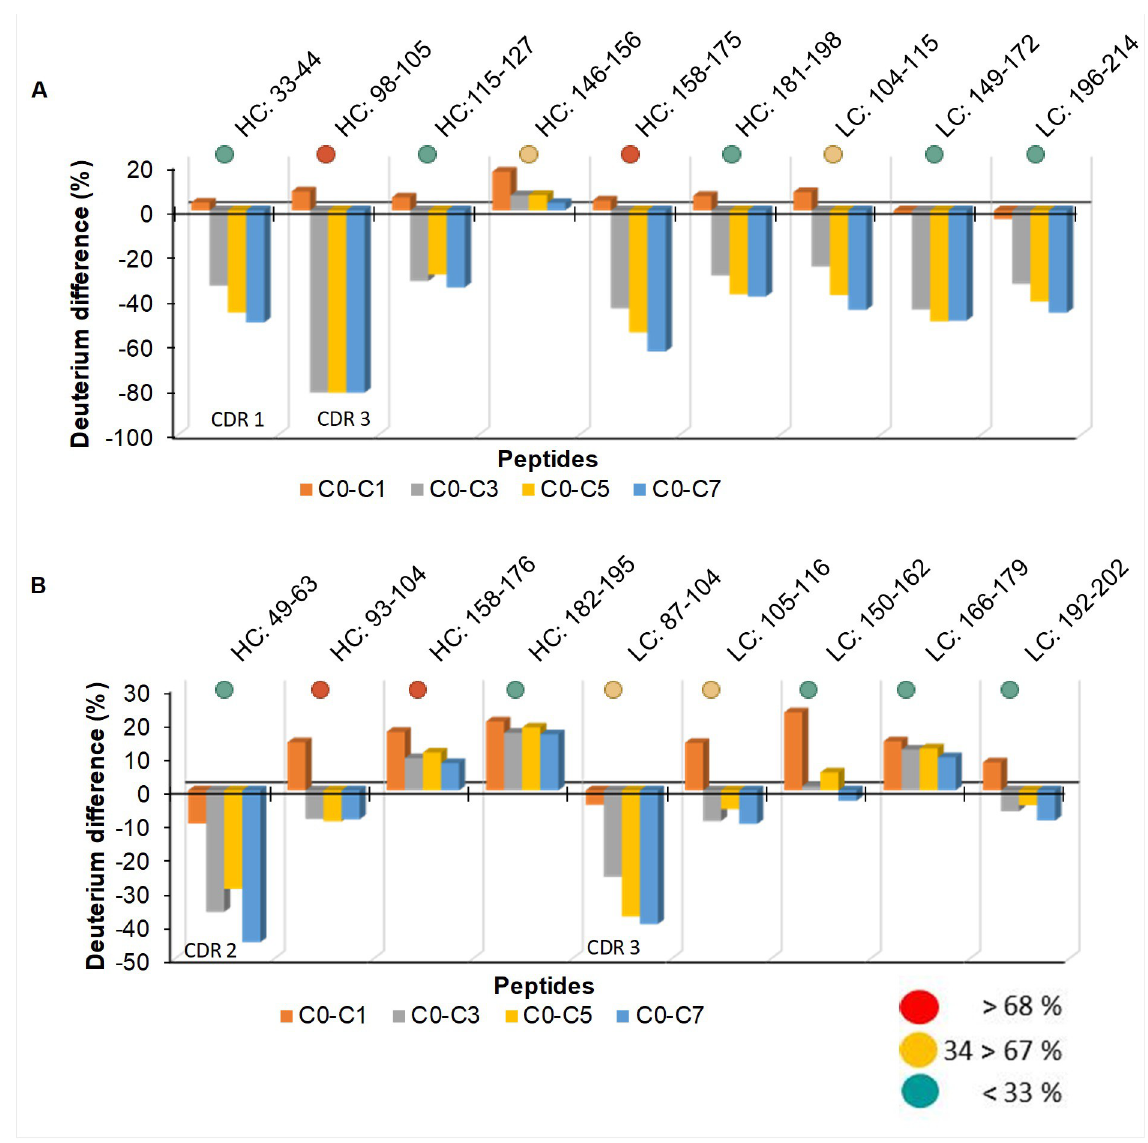
Fig 6. Differences in deuterium incorporation for E559 (A) and 62-71-3 (B) and their contribution to the SAP aggregation score. Deuterium incorporation in cycle 0 was deducted from cycle 1, 3, 5 and 7. The contribution of each peptide to the SAP aggregation score was calculated, red circles indicate high contribution, yellow is medium contribution and green is low